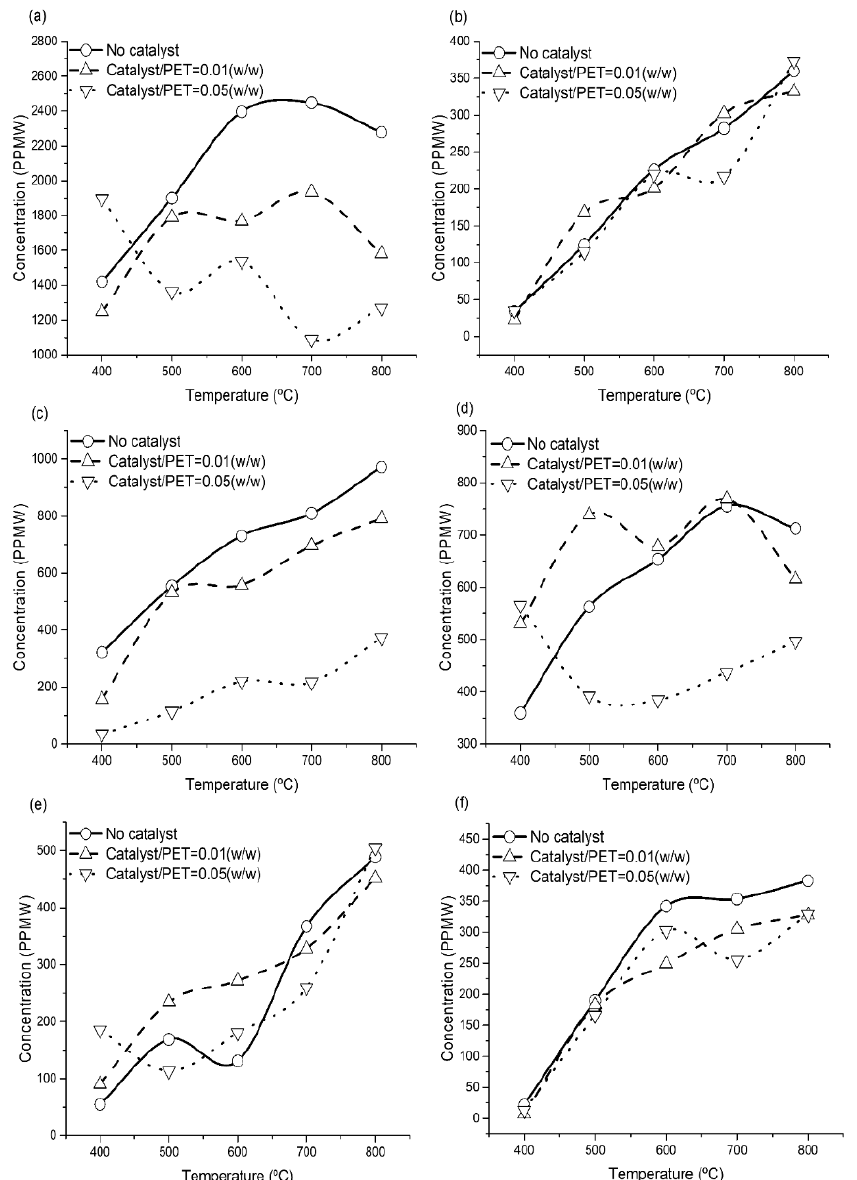
Figure 1. The type of biphenyl derivative concentration obtained from the pyrolysis of polyethylene terephthalate (PET) with and without Pd catalyst. ( a ) 2-naphthalenecarboxylic acid, ( b ) fluorenone, ( c ) triphenylene, ( d ) biphenyl-4-carboxylic acid, ( e ) p -terphenyl, and ( f ) o -terphenyl. Two kinds of amine species (6 ′ -hydroxy-5 ′ -methoxy-1 ′ -methyl-2 ′ ,3 ′,8,’8a’ -tetrahydro-1 ′ H- spiro[cyclohexa[2,5]diene-1,7 ′ -cyclopehnta[ij]isoquinolin]-4-one and 2,3,7,8-tetramethoxy-12- methyl-4b,5,11,12-tetrahydrobenzo[c]phenanthridine) were generated from the pyrolysis of PET. As